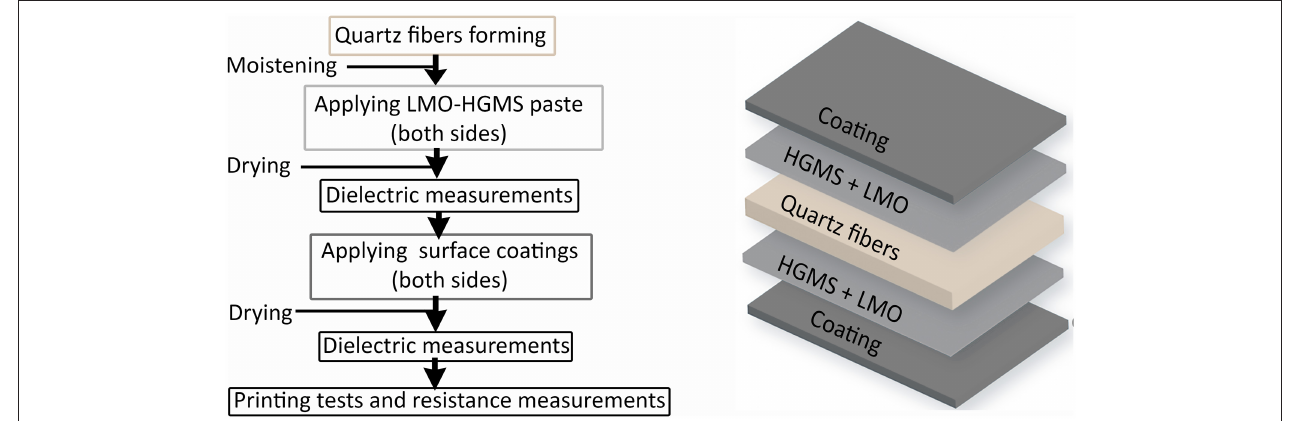
FIGURE 1 | (Left) Flow diagram of sample preparation process. (Right) Structural layers of the